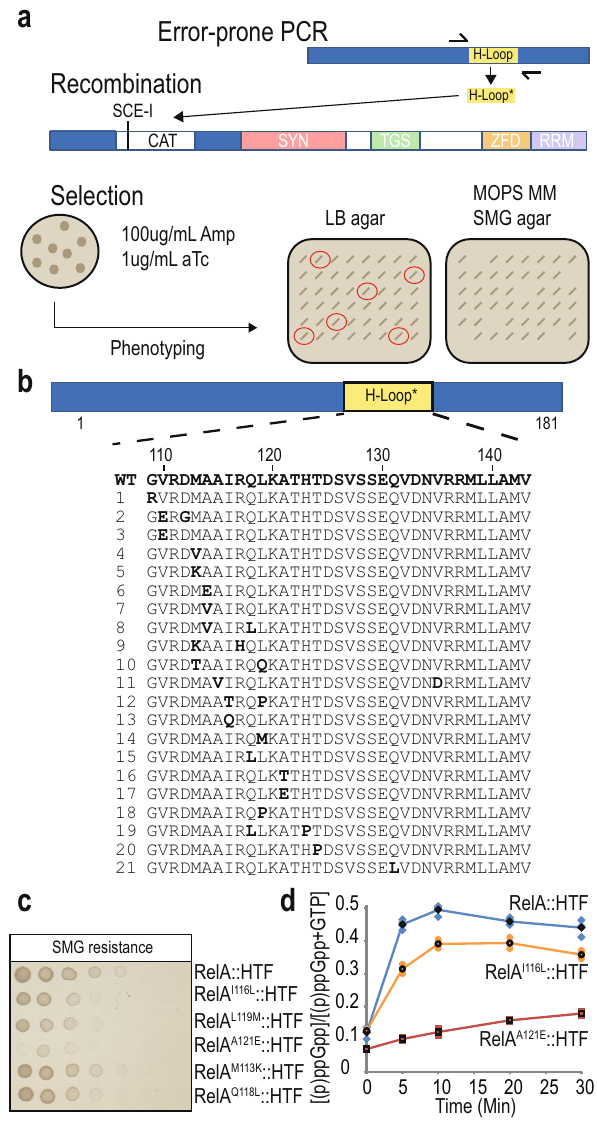
recombination 36 . Mutants were isolated and screened on SMG plates. H-loop mutants showing growth defects were subse- quently isolated and sequenced (Fig. 2b). Interestingly, a majority of substitutions (21 different, independently isolated mutants)